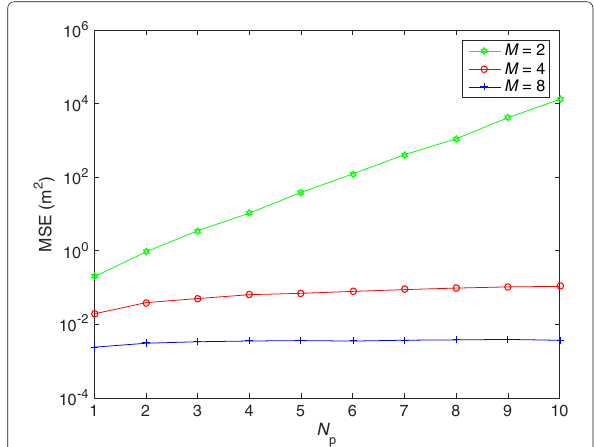
Fig. 4 Numerical result 2. MSE versus M with B as a parameter, for δ = 10 ns, ρ = 0 dB, and N = 5 P